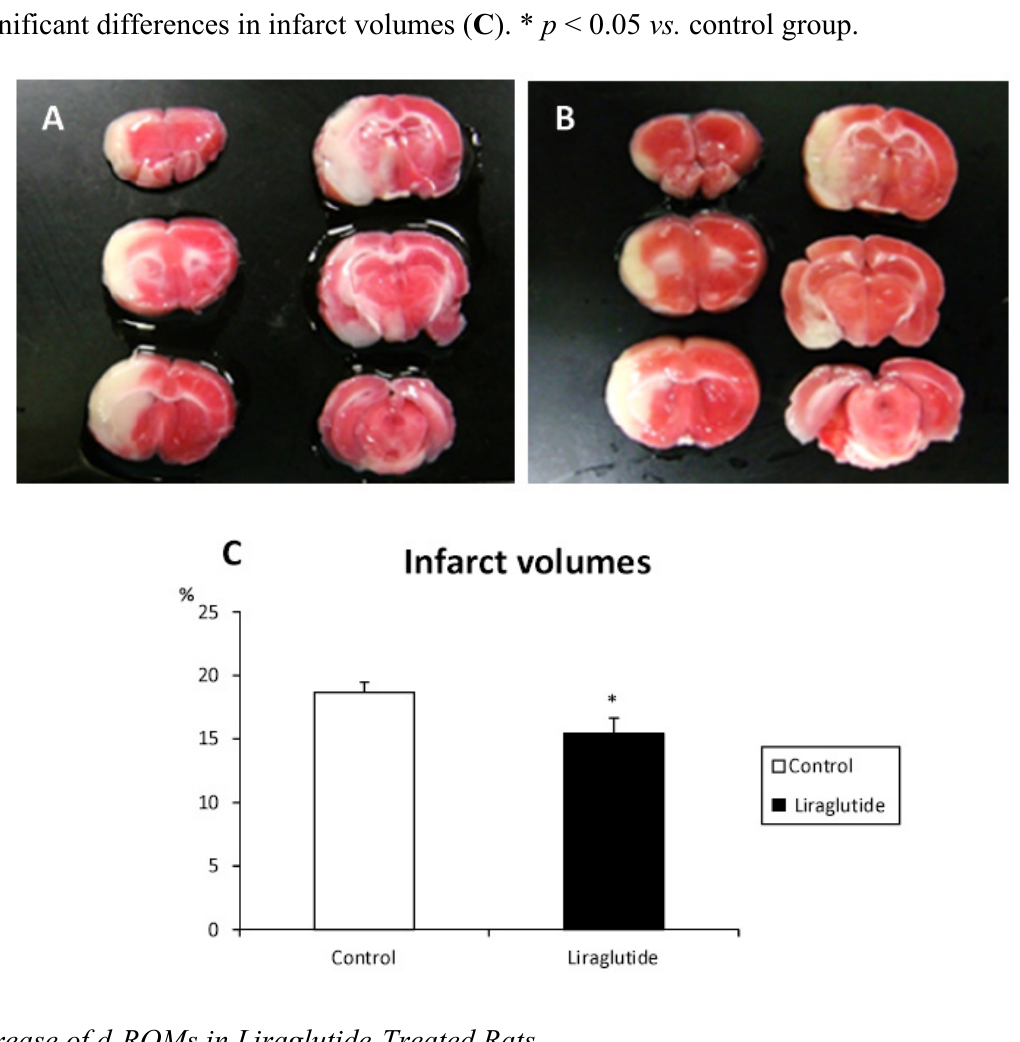
Figure 3. Reduced infarct volumes in rats receiving liraglutide. Representative images of TTC staining of rats in control ( A ) and liraglutide-treated groups ( B )